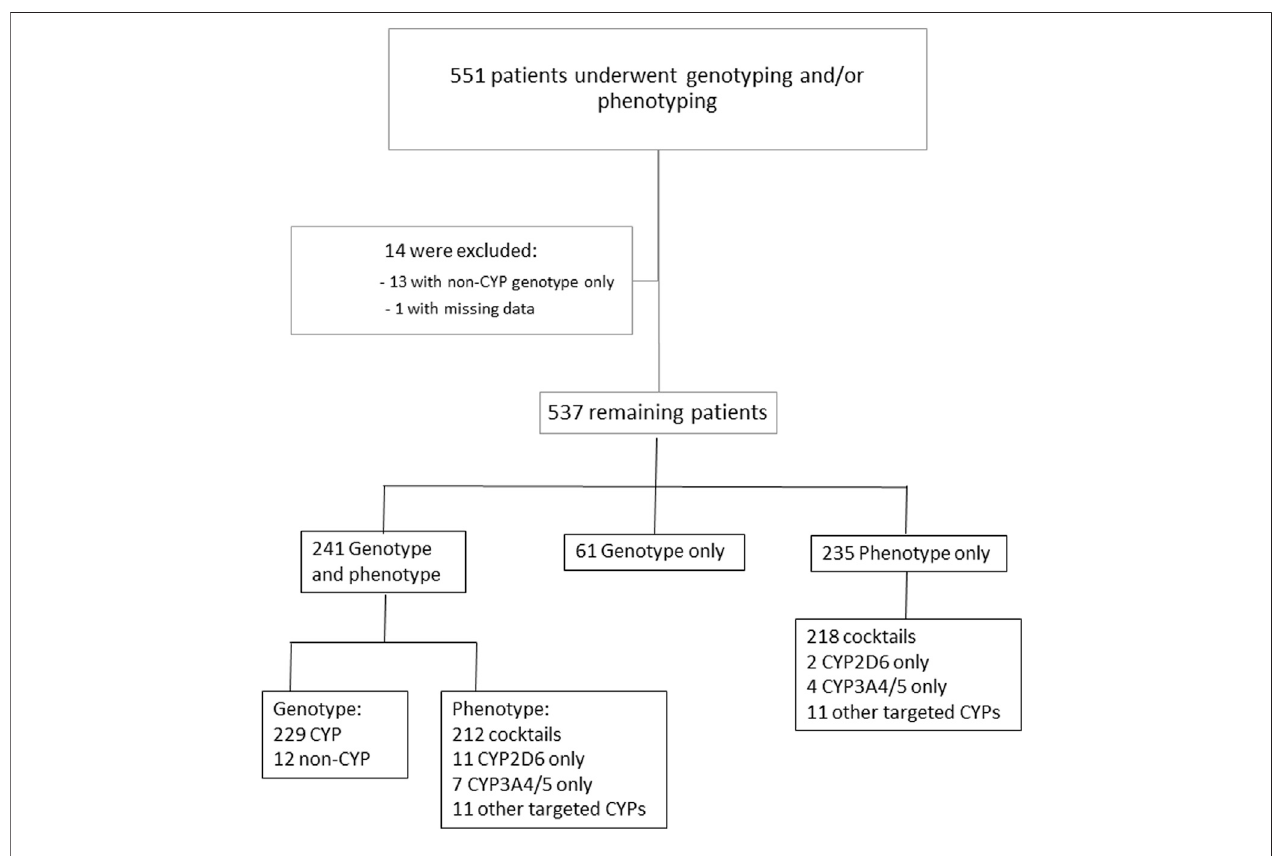
FIGURE 1 | Study fl owchart.